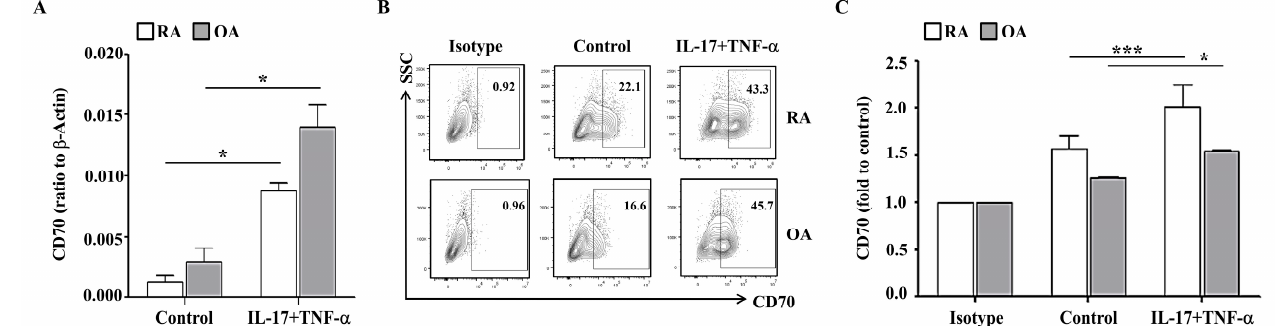
Figure 1. IL-17 and TNF- α stimulate CD70 expression in RA FLS and OA FLS. ( A ) RA FLS ( n = 3; white bar) and OA FLS ( n = 4; grey bar) were cultured with or without IL-17 (5 ng/mL) and TNF- α (5 ng/mL) for 24 h. CD70 mRNA levels were quantified using RT-PCR and β -actin as a housekeeping gene. Statistical differences between groups were determined using a Mann–Whitney test. ( B ) RA FLS and OA FLS were stimulated with or without IL-17 (5 ng/mL) and TNF- α (5 ng/mL) for 24 h. ( C ) RA FLS ( n = 14; white bar) and OA FLS ( n = 4; grey bar) were stimulated with or without IL-17 (5 ng/mL) and TNF- α (5 ng/mL) for 24 h. To analyze the surface expressions of CD70, flow cytometry was performed using PE-conjugated anti-CD70. Average CD70 expression is displayed as fold change of the mean fluorescence intensity (MFI) compared to control. Data are presented as mean ± standard deviation. Statistical analysis was performed by using a Mann–Whitney test (RA) or a paired t -test (OA). * indicates p < 0.05. *** indicates p < 0.001.